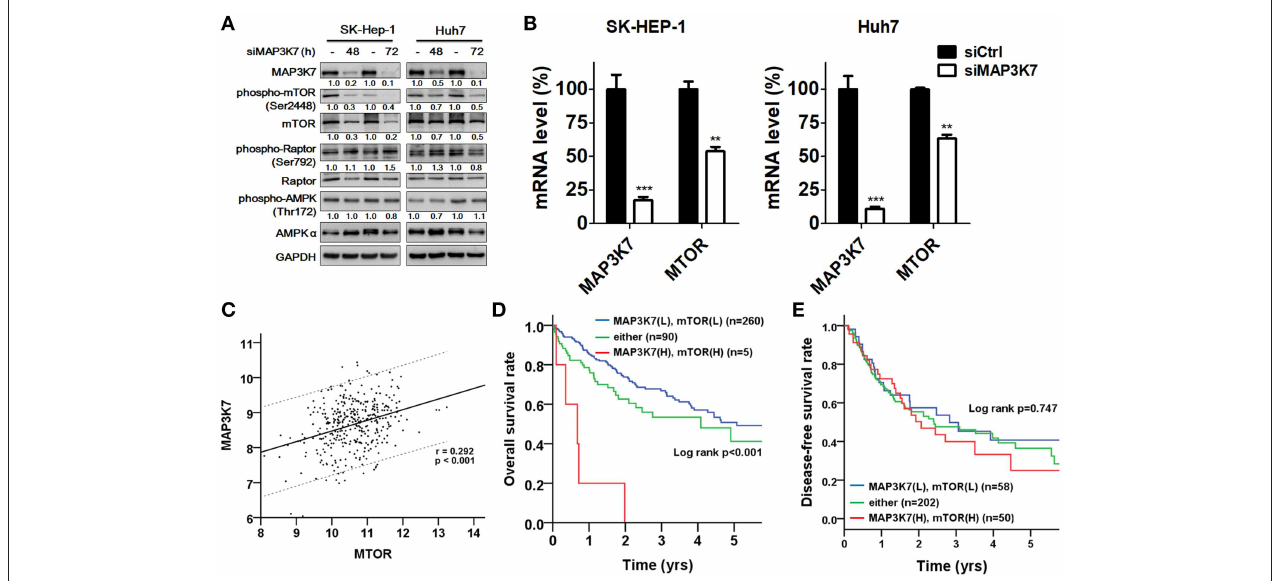
FIGURE 6 | Correlation of MAP3K7 and mTOR in HCC. (A) SK-HEP-1 and Huh7 cells were transfected with scramble siRNA or siRNA against MAP3K7 for 48 or 72h. The effects of silencing MAP3K7 on mTOR and p-(S2448)-mTOR were examined by immunoblotting using GAPDH as a control. (B) The gene expression of mTOR in MAP3K7 knockdown cells was determined by real-time PCR. (C) TCGA HCC dataset ( n = 355) was used to analyze the correlation between MAP3K7 and mTOR expression in tumor tissues through the Pearson χ 2 test. (D) Kaplan-Meier analysis was used to evaluate the effect of the co-expression of MAP3K7 and mTOR on overall survival and (E) disease-free survival. ** p < 0.01; *** p <